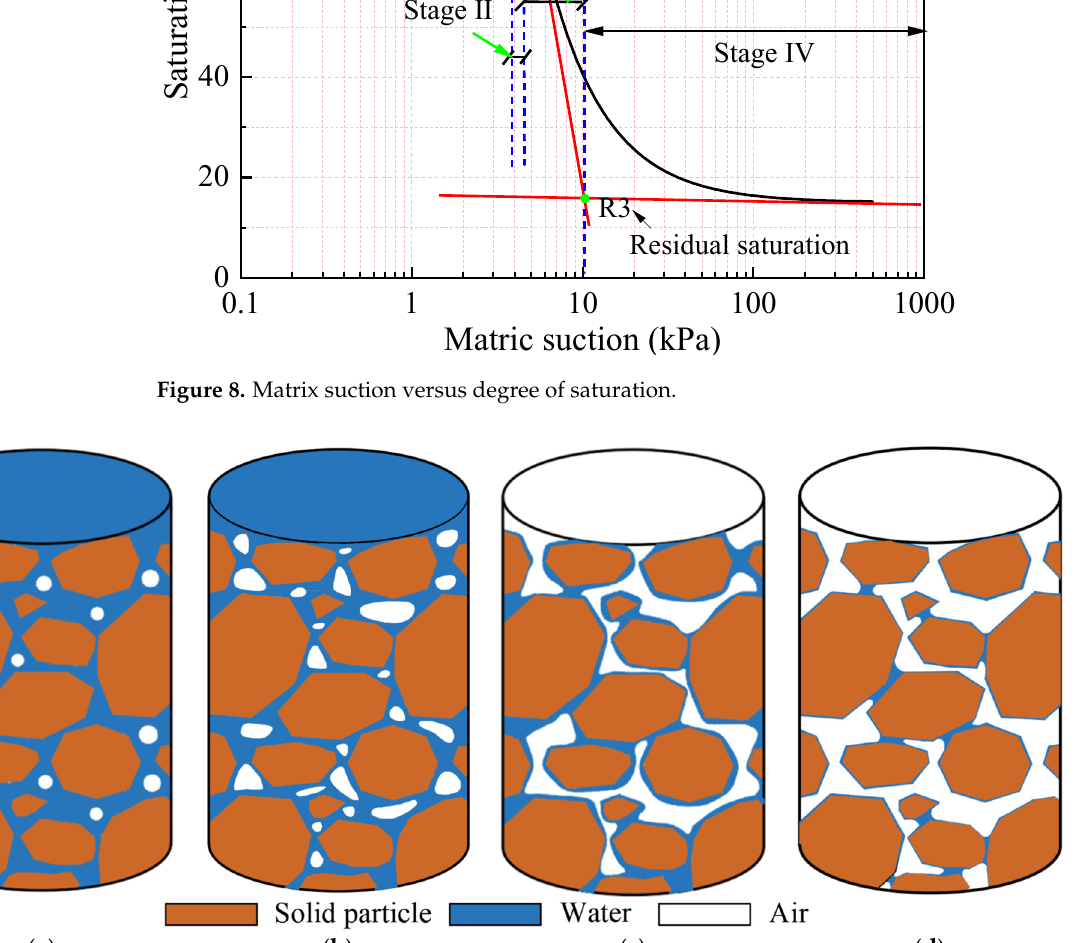
Figure 9. Distribution pattern of pore water within the four stages. ( a ): Stage Ⅰ ; ( b ): Stage Ⅱ ; ( c ): Stage ⅠII ; ( d ): Stage Ⅳ .